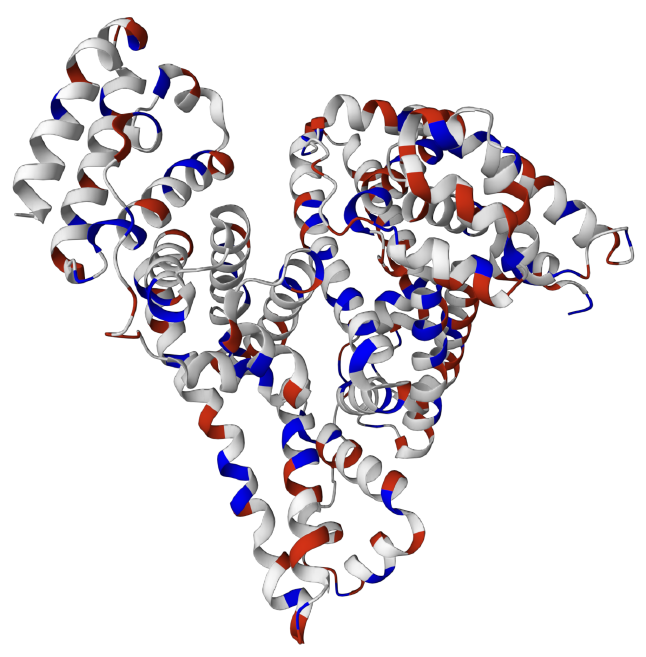
Figure 1. Crystal Structure of Bovine Serum Albumin [32]. Here, the blue ones are positively charged groups, the red ones are negatively charged, and the white ones are non-polar